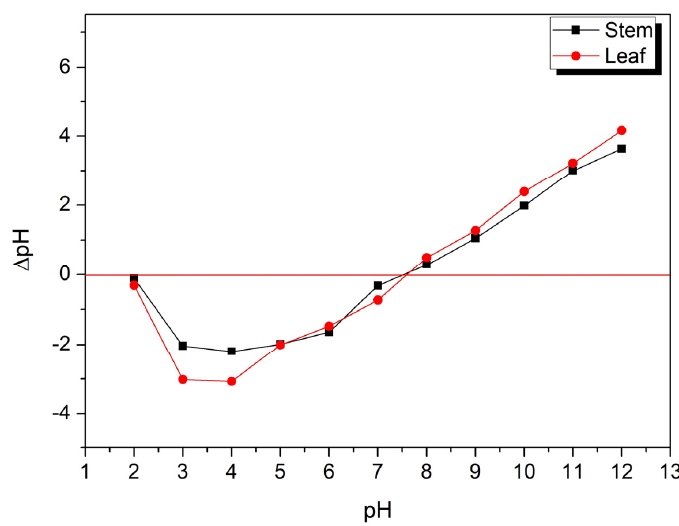
Figure 2. Representation of pH pzc for water hyacinth stem and leaf materials.